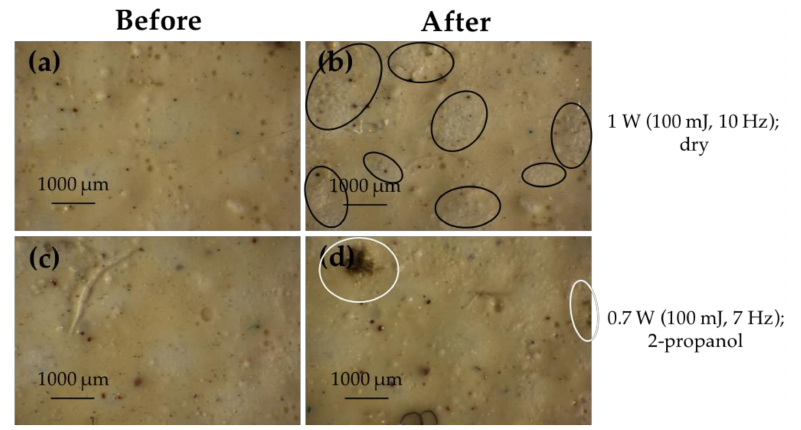
Figure 3. The microscopic images (32 × ) of mastic removal by Er:YAG laser under varied conditions and parameters, conducted on lead white tempera mock-ups. ( a , b ) was obtained before and after cleaning in dry condition with 1 W as laser power, and ( c , d ) is image before and after cleaning in wet (2-propanol) condition with 0.7 W as laser power.